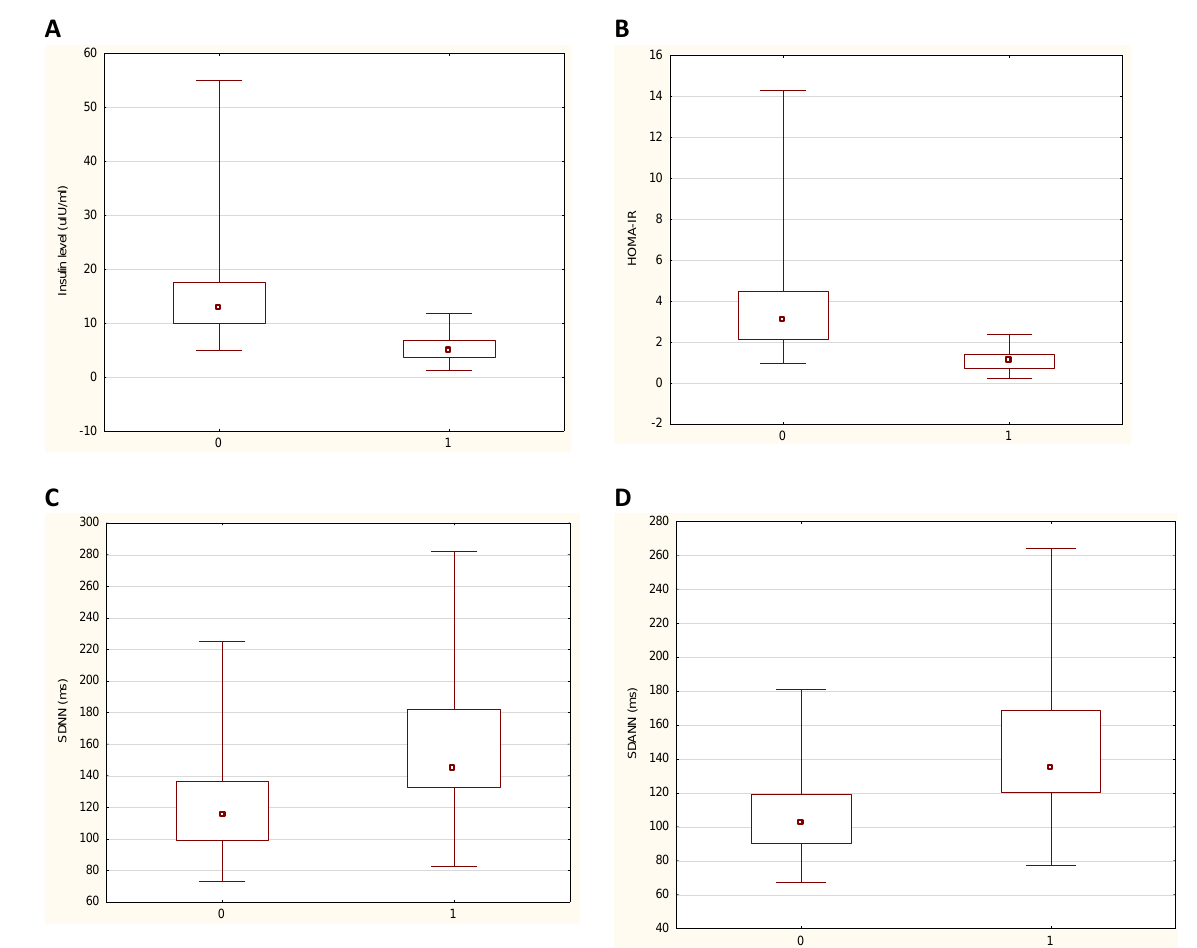
Figure 1. The values of fasting insulin level (chart A ), homeostatic model assessment for insulin resistance HOMA-IR (chart B ), SDNN (chart C ) and SDANN (chart D ) in 50 patients before and after weight loss. Charts present medians with ranges’ values, while detailed results are shown in Table 2 ( Y -axis: 0—patients before bariatric surgery, 0—patients after weight loss). Table 2. Anthropometric obesity parameters, additional diseases and parameters of carbohydrate metabolism results in patients before and after bariatric surgery.